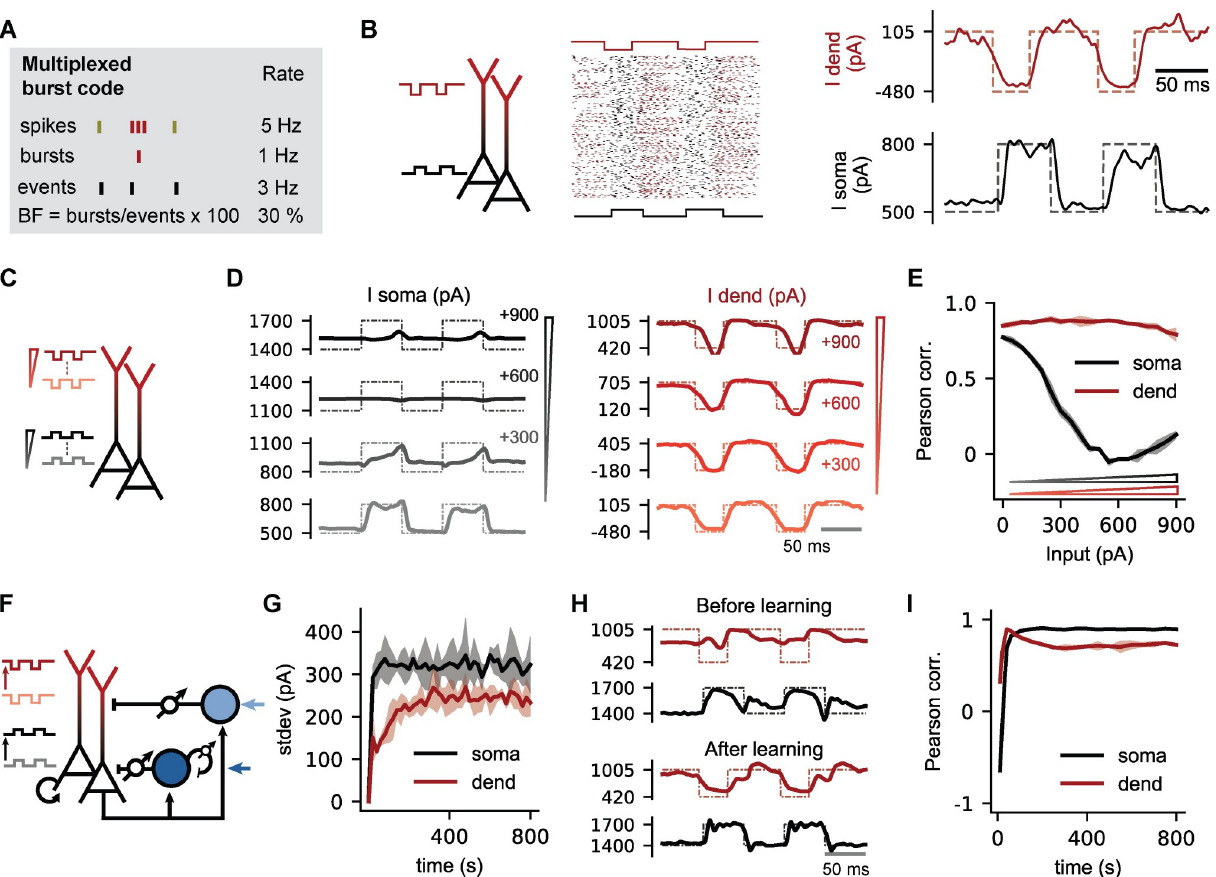
Fig 4. Inhibitory plasticity self-organises a multiplexed burst code. (A) Example illustrating a multiplexed burst code in PCs in which somatic and dendritic inputs are represented in the event rate and the burst fraction, respectively [17]. Events are either a burst or single spike, while the burst fraction (BF) is the fraction of events that are bursts. (B) Alternating and opposite pulse inputs (dashed lines) are delivered to the somatic and dendritic compartment ( I s ; high ¼ 800 pA , I s ; low ¼ 500 pA , I d ; high ¼ 105 pA , I d ; low ¼ (cid:0) 480 pA , s s ¼ s d ¼ 450 pA ). The pulse inputs can be decoded from the i i i i i i event rate (solid black) and BF (solid red) respectively (see Methods). (C) Stimulation paradigm with an increase in background excitation (300, 600 and 900 pA; red triangle = dendrite, black triangle = soma) on which pulse inputs are superimposed. (D) Comparison of somatic input/event rate (left) and dendritic input/burst probability (right). Event rate and BF were rescaled using a linear decoder. Dashed lines represent the true inputs. The multiplexed code deteriorates when dendritic and somatic background currents are increased relative to Fig 4B. The values on the y-axis are external input strengths in pA. (E) Quality of the multiplexed burst code for increased background excitation, measured by the Pearson correlation coefficient between the two input currents and event rate (black) and burst fraction (red), respectively (see Methods). (F) Inhibitory plasticity restores the multiplexed burst code in a biological microcircuit without the need for fine-tuning the background input or noise levels. The microcircuit is similar to Fig 3, with constant external inputs, recurrent connections and plasticity on all inhibitory connections. Background excitation to both somatic and dendritic compartments was increased with 900 pA, where event rate (BF) is not informative of somatic (dendritic) input pulses. (G) The learning process increases the standard deviation of the net dendritic (red) and somatic (black) input currents. (H) Decoded inputs from the event rate (black) and BF (red) before and after learning, as in D. (I) Pearson correlation between actual and decoded inputs to quantify the quality of the multiplexed burst code over the course of learning (see